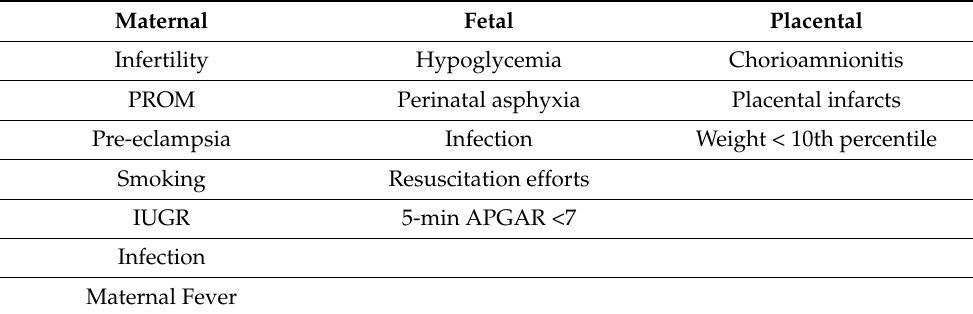
Table 1. Various risk factors for perinatal